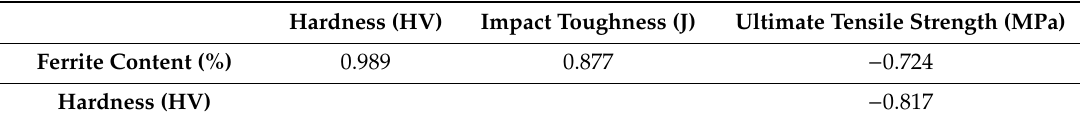
Table20. Pearsoncorrelationcoe ffi cientbetweenferritecontentandmechanicalpropertiesofmartensitic stainless steel.